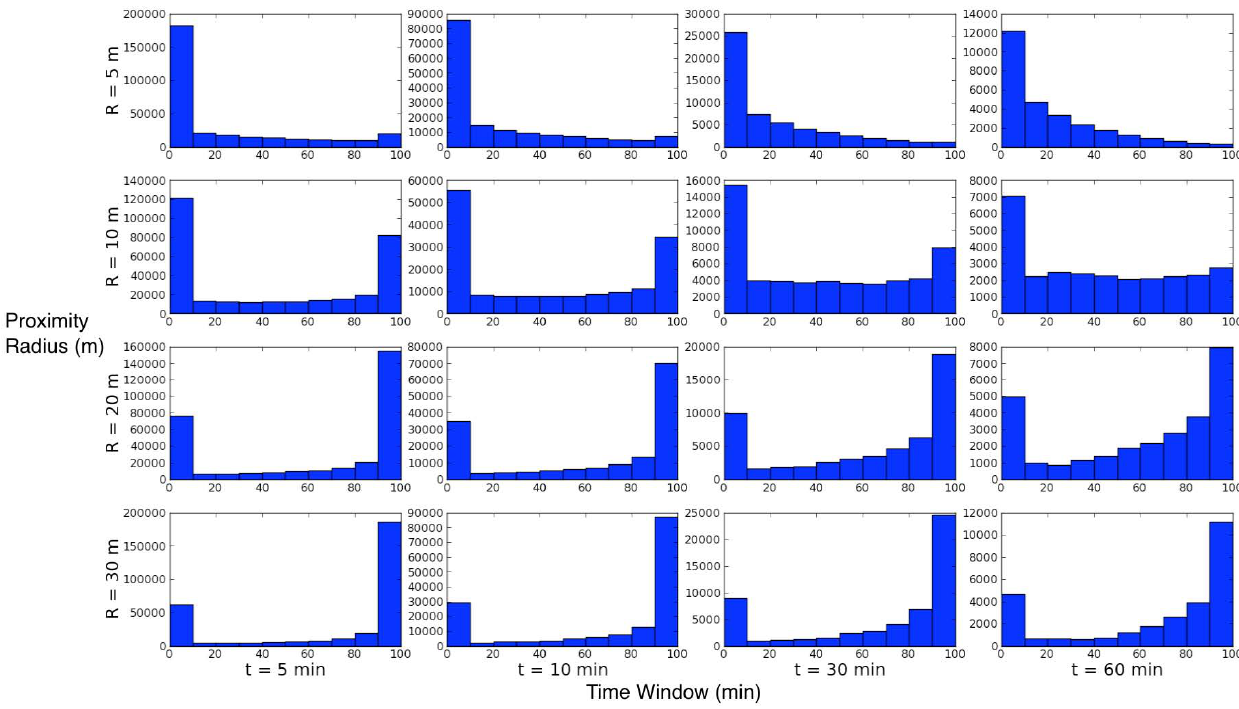
Figure 14. The joint impact of the proximity radius R and the time window T